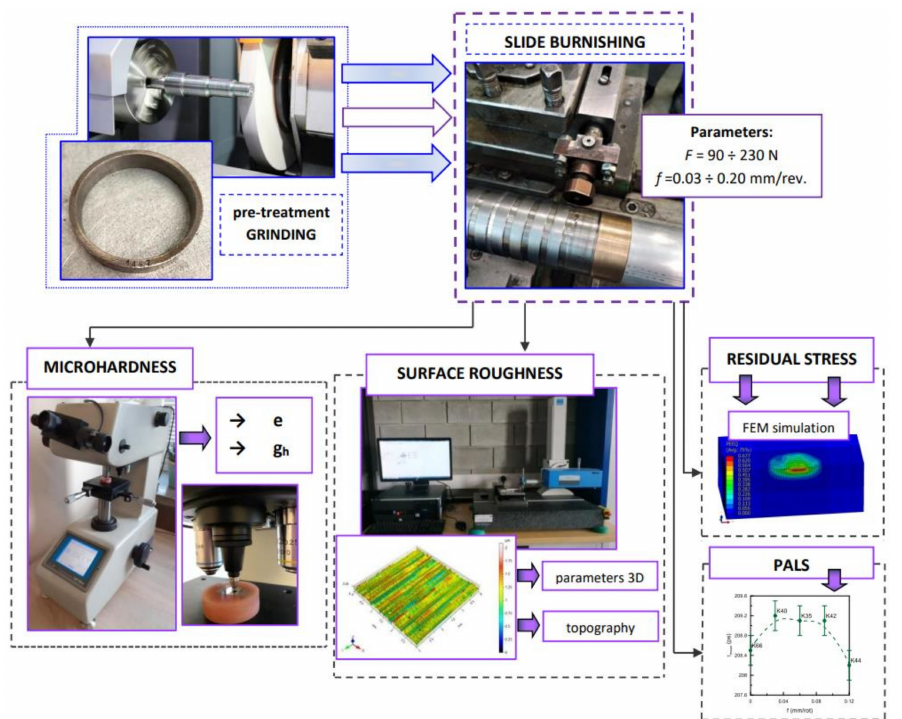
Figure 2. Methodology of the conducted research. The parameters of the experiment, stands research and achieved